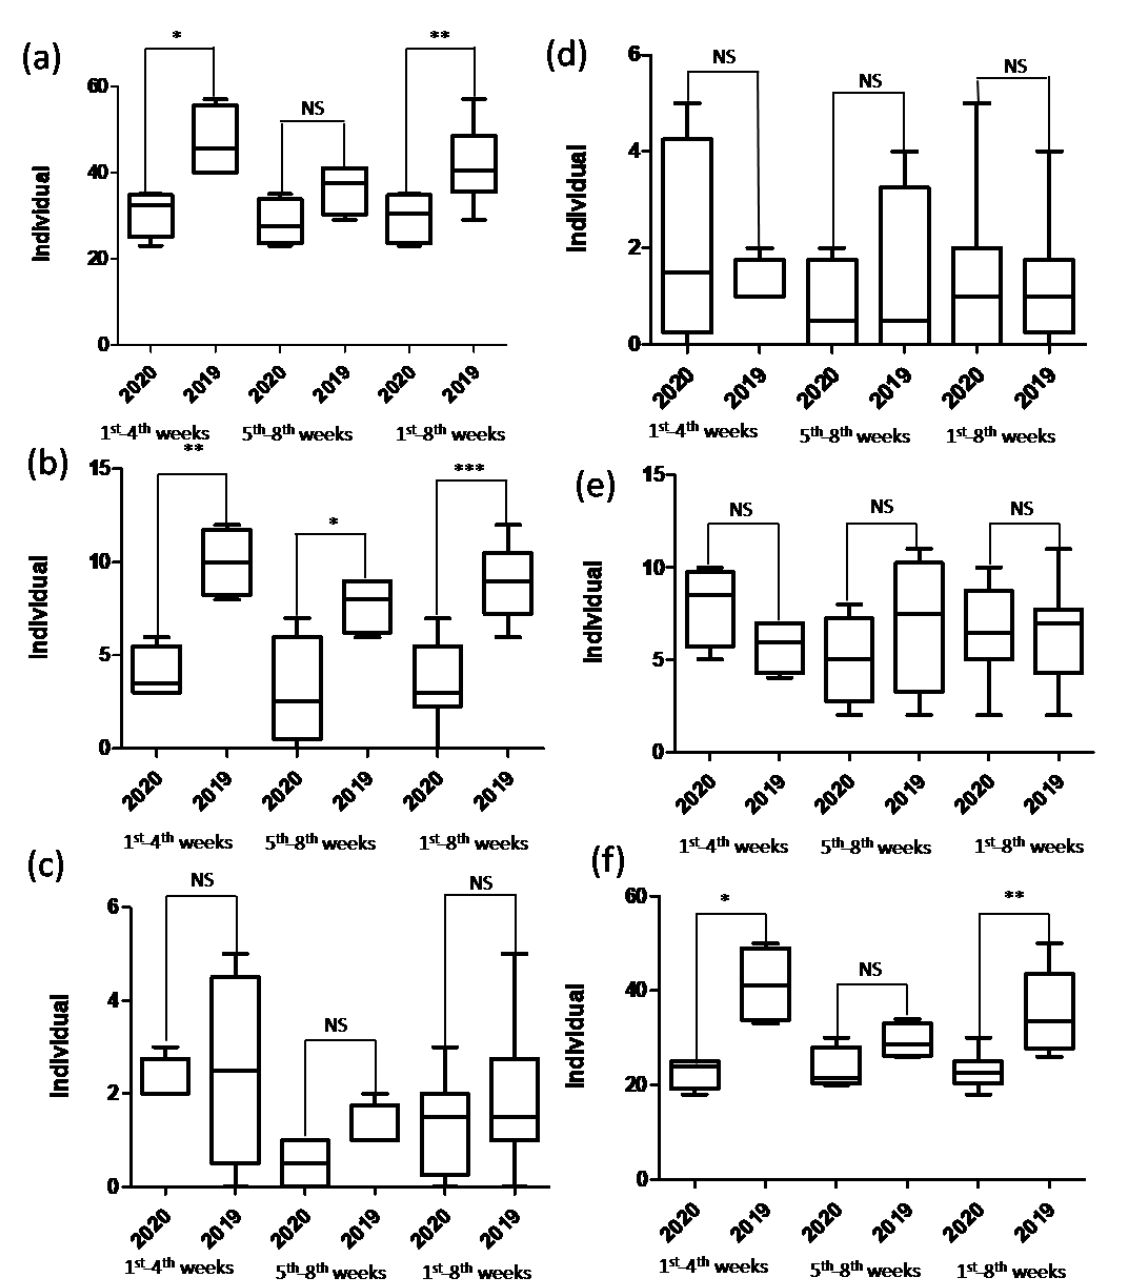
Figure 3. Box plots of the number of patients receiving the ( a ) total types of surgery, ( b ) total knee arthroplasty, ( c ) total hip arthroplasty, ( d ) hemiarthroplasty, ( e ) emergency surgery, and ( f ) elective surgery at the community hospital during the study (2020) and control (2019) periods. * indicates p < 0.05. ** indicates p < 0.01. *** indicates p < 0.001. “NS” indicates insignificant.